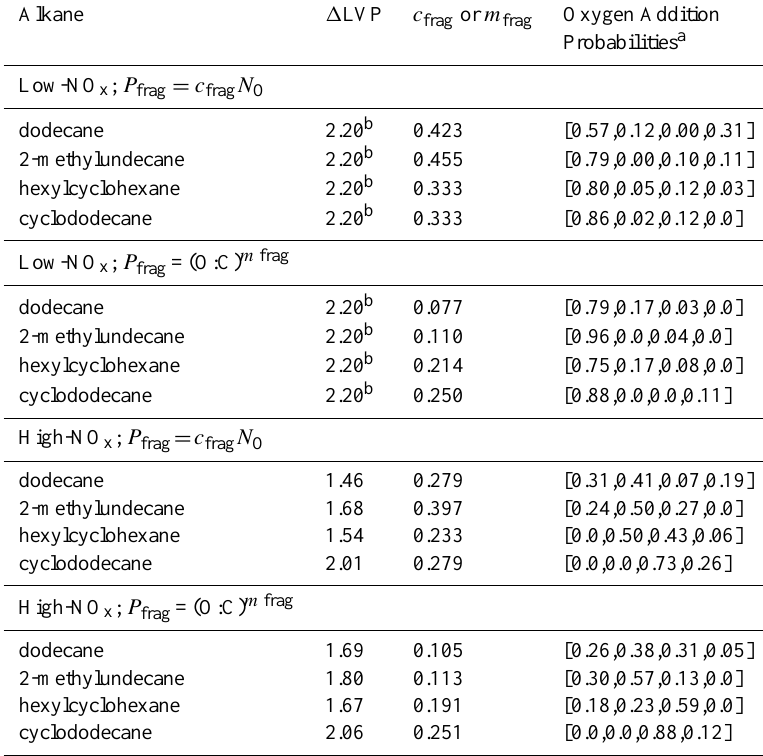
Table 2. Statistical oxidation model best-fit parameters when fit to both C OA and O:C. Alkane 1 LVP c frag or m frag Oxygen Addition Probabilities a Low-NO x ; P frag = c frag N O dodecane 2.20 b 0.423 [0.57,0.12,0.00,0.31] 2-methylundecane 2.20 b 0.455 [0.79,0.00,0.10,0.11] hexylcyclohexane 2.20 b 0.333 [0.80,0.05,0.12,0.03] cyclododecane 2.20 b 0.333 [0.86,0.02,0.12,0.0] Low-NO x ; P frag =(O:C) m